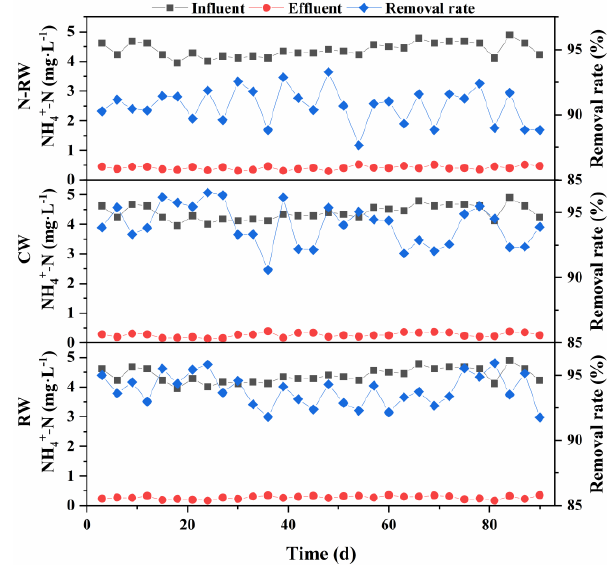
Figure 2. Changes of NH 4+ -N concentration and corresponding removal rate in influent and effluent of three groups of wetland systems.